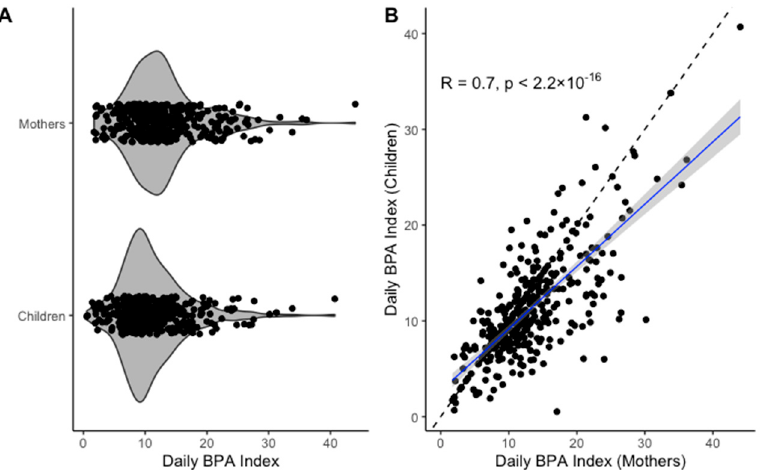
Figure 1. Comparison of daily BPA indices for mothers and children: ( A ) sina with violin plot of daily BPA indices for mothers and children; ( B ) correlation plot of daily BPA indices for mothers and children; R, Spearman’s rho; solid line represents fitted line and dashed line represents y = x .